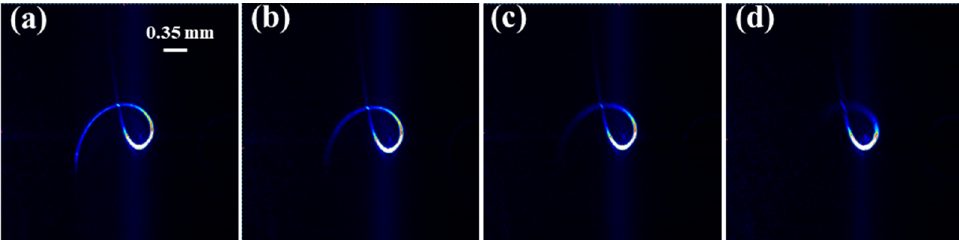
Figure 7. ( a – d ) CCD-captured intensity patterns of the customized spoon-like beams generated with the phase profiles in Figure 4a–d, respectively.